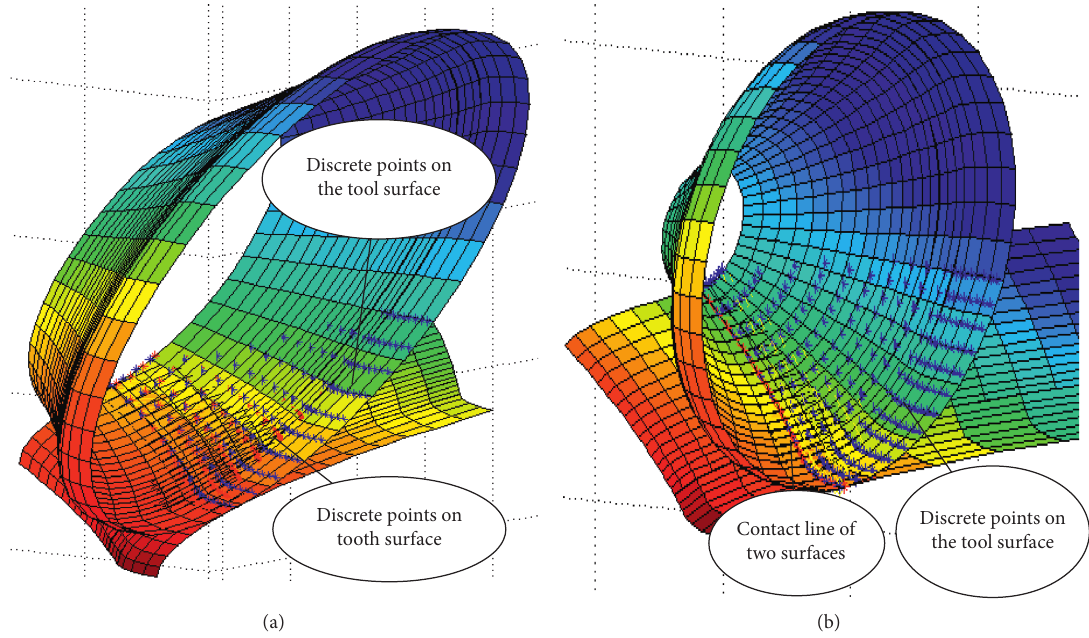
Figure 8: Cutter check drawings for different diameters. (a) Drawing for the larger diameter tool. (b) Drawing for the smaller diameter tool.